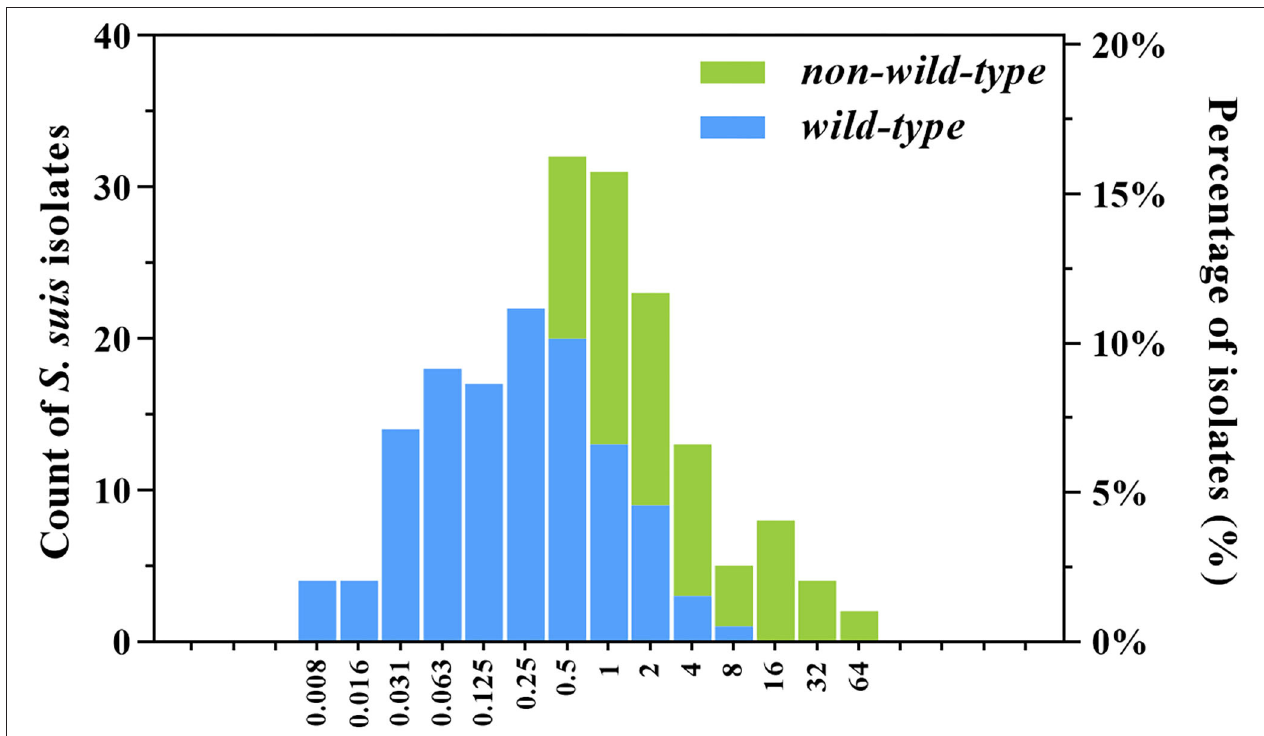
FIGURE 1 | Wild-type and non-wild-type minimum inhibitory concentration (MIC) distributions for gamithromycin against clinical Streptococcus suis isolates from swine in China. The isolates harbored the macrolide resistance mechanisms such as ermA , ermB , mefA , and msrD genes (non-wild-type; n = 72) were consequently excluded from the primitive distribution ( n = 197) to obtain the wild-type MIC distribution ( n = 125). The number of S. suis isolates (left y -axis) and their observed frequency (right y -axis) corresponding to each MIC are shown along the y -axis.